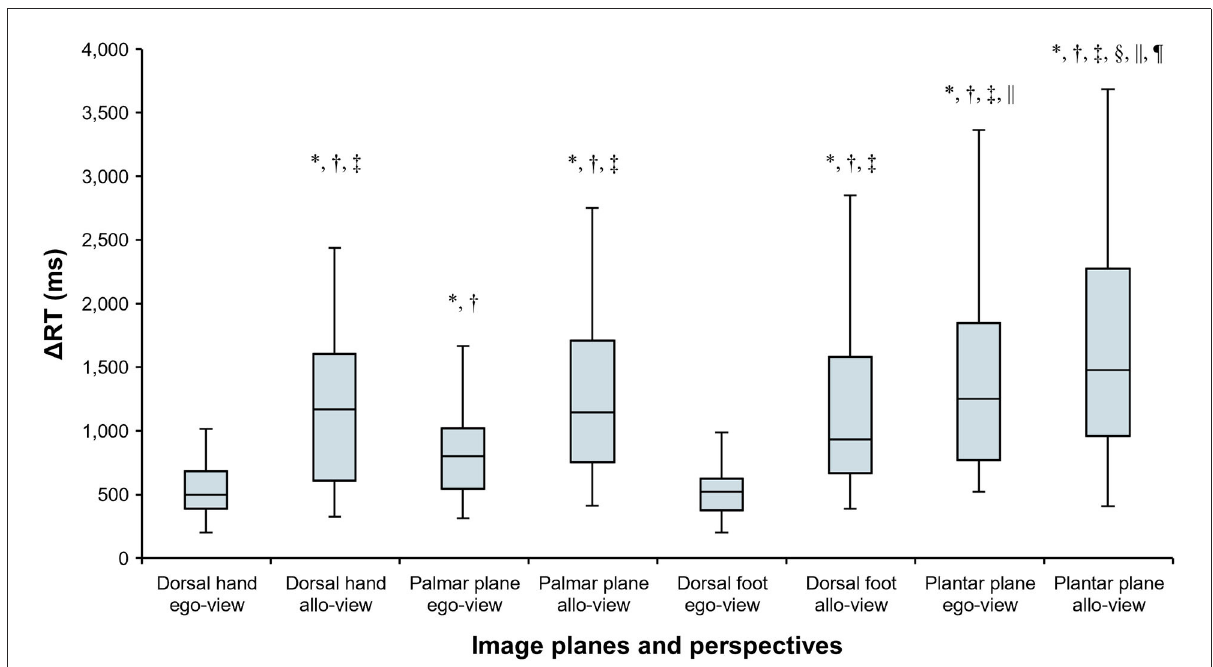
FIGURE6 Comparisons of 1 RTs in individual image planes (dorsal hand, palmar plane, dorsal foot, and plantar plane) and perspectives (ego-view and allo-view). Data are shown as median and interquartile range. * response time ( 1 RT) is significantly slower than that in the egocentric view (ego-view) of the dorsal hand. † 1 RT is significantly slower than that in the ego-view of the dorsal foot. ‡ 1 RT is significantly slower than that in the ego-view of the palmar plane. § 1 RT is significantly slower than that in the allocentric view (allo-view) of the dorsal hand. || 1 RT is significantly slower than that in the allo-view of the dorsal foot. ¶ 1 RT is significantly slower than that in the allo-view of the palmar plane (all p < 0.002).